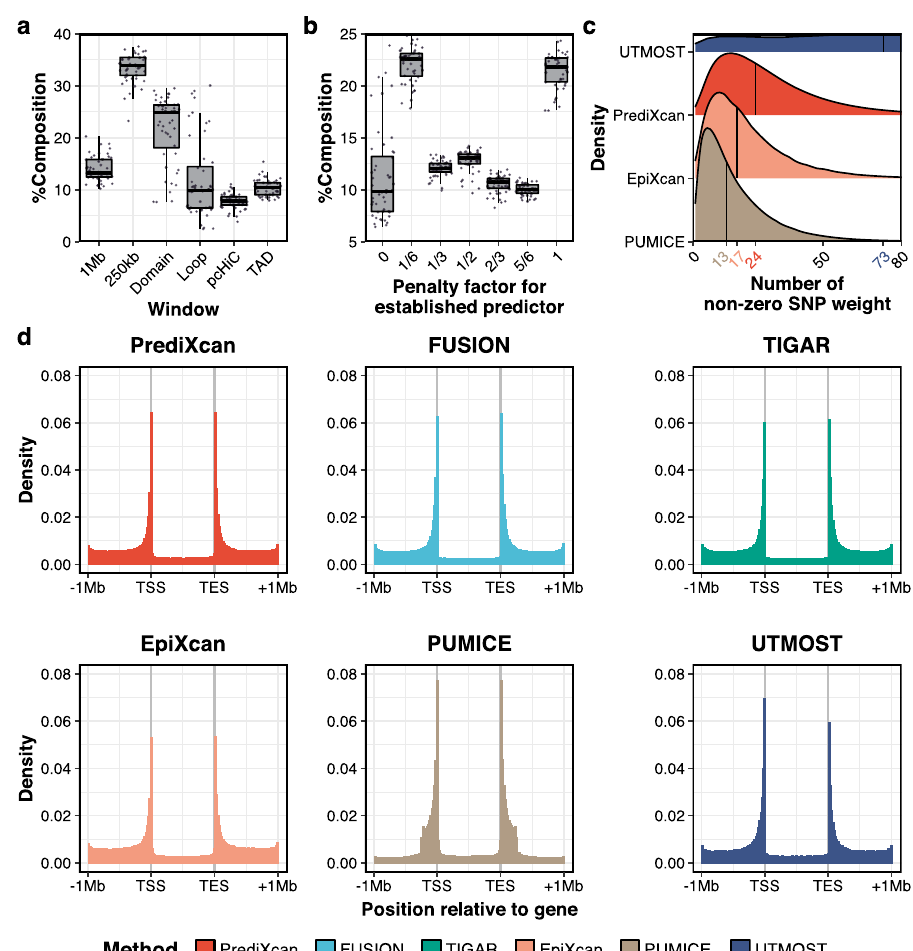
Fig. 4 Characteristics of GTEx gene expression prediction models. In panel ( a ), we illustrate the proportions of different window sizes w among selected PUMICE models. Each boxplot is derived from the percent window composition of 48 GTEx tissues. In panel ( b ), we show the proportion of different values of tuning parameter ϕ among selected PUMICE models. ϕ is the tuning parameter that reduces the L 1 and L 2 penalties for essential predictors that overlap with ENCODE annotations. Each boxplot is derived from the percent penalty factor composition of 48 GTEx tissues. Minima and maxima values (excluding outliers) are represented by the lower- and upper-bound of the whiskers. Median value is represented by the bolded line in the middle. First and third quartiles are represented by the lower- and upper-bound of the box. In panel ( c ), we show the distribution of the number of SNPs with non-zero weights in gene expression prediction models across different TWAS methods. Vertical line represents median number of SNPs with non-zero weights. PUMICE models have the lowest median number of SNPs with non-zero weights ( n = 13), while UTMOST models have the highest median number of SNPs with non-zero weights ( n = 73). In panels ( d ), we plot the distribution of the locations of SNPs with non-zero weights (for PrediXcan, EpiXcan, PUMICE, and UTMOST) or top 100 SNPs with highest weights (for FUSION and TIGAR). Variant counts are plotted against their locations relative to 5 ’